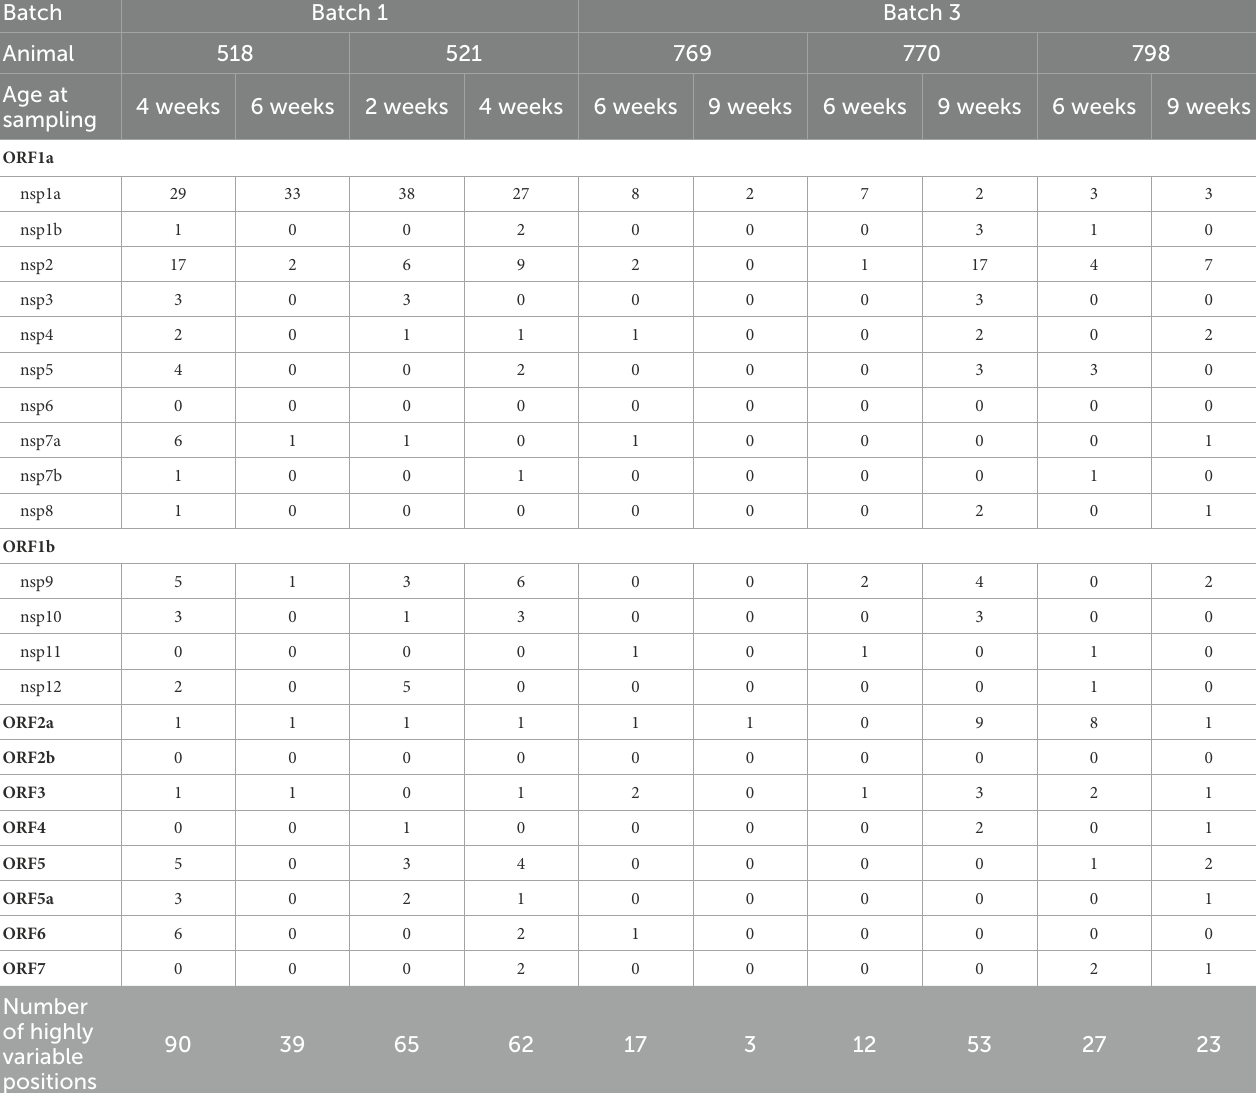
TABLE 3 Summary of highly variable positions (positions showing overall mutation frequencies higher than 10%) in the 10 viral quasi-species analyzed, and location of those positions in the PRRSV-1 genome. Batch Batch 1 Animal